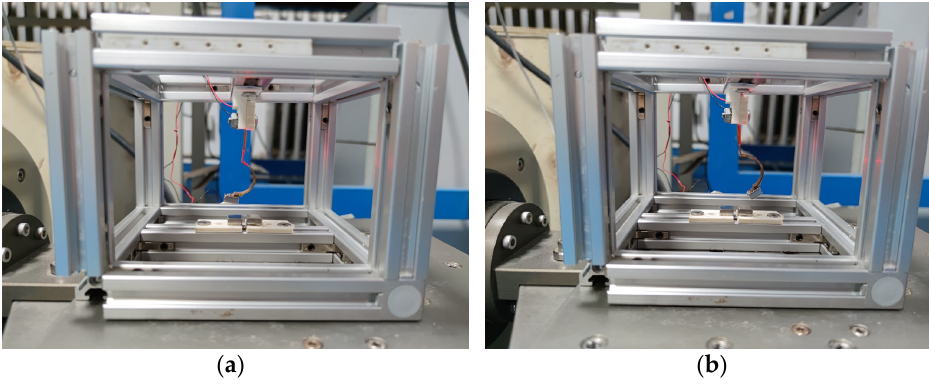
Figure 13. Two stable equilibrium positions: ( a ) stable1; ( b ) stable2.